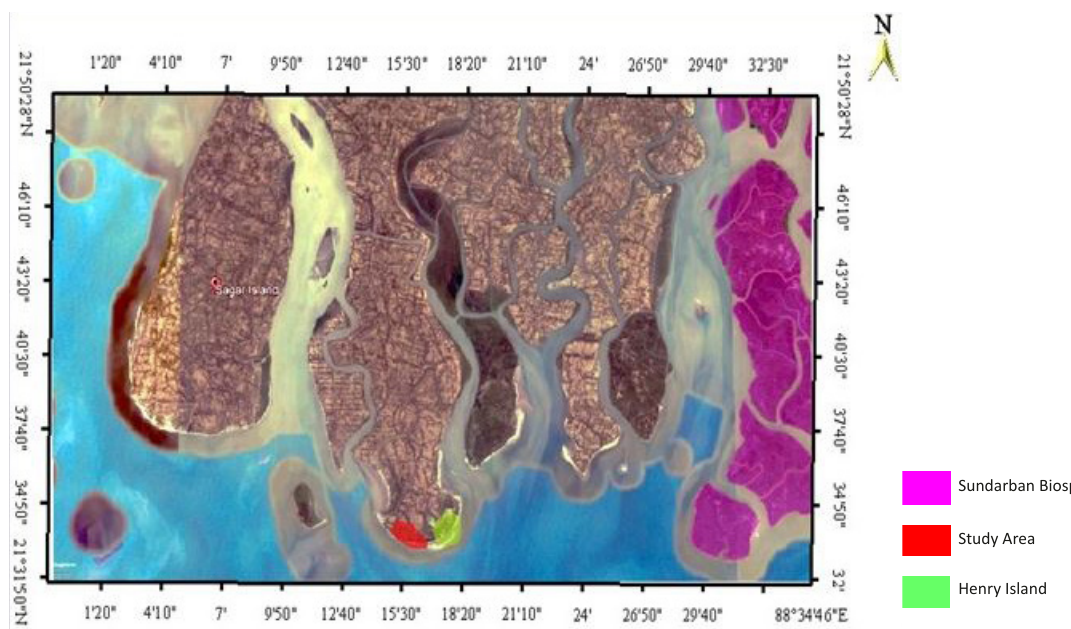
Figure 1. Geographic information system for field study area at Frezerganj Wind Farm, Bakkhali (South 24-Parganas; West Bengal; 87.916– 94.051 0 E and 21.552–25.533 0